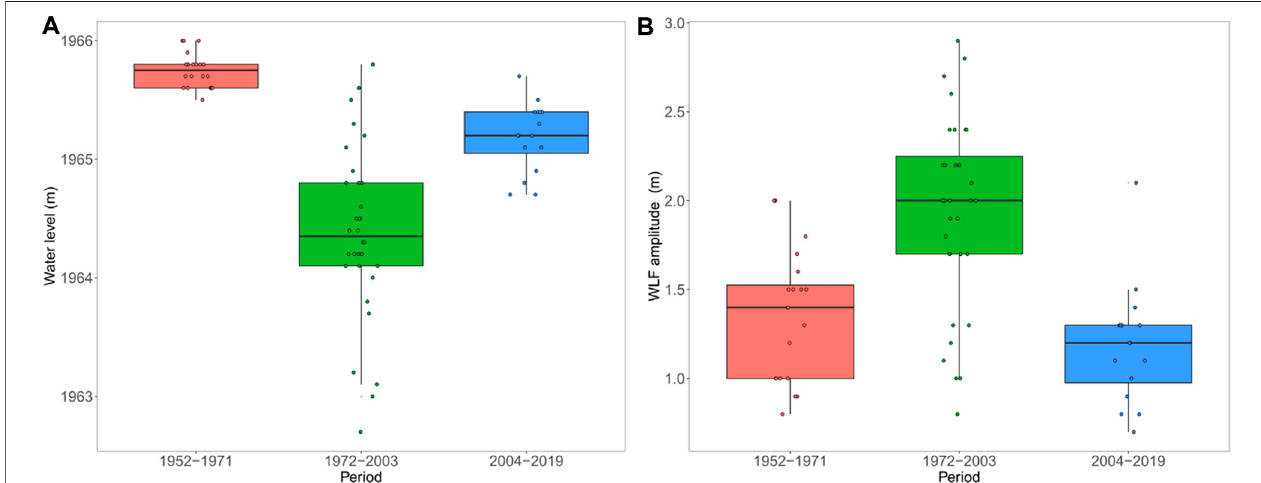
FIGURE 3 | Box plots on water level (A) and its fl uctuation (WLF) (B) in Erhai Lake in 1952 – 1971, 1972 – 2003, and 2004 – 2019 periods. Lower, middle, and upper lines of box indicate fi rst quantile, median, and third quantile of data, respectively. Vertical line indicates values within 1.5 interquartile range below the lower quartile and above the upper quartile. Dots are yearly